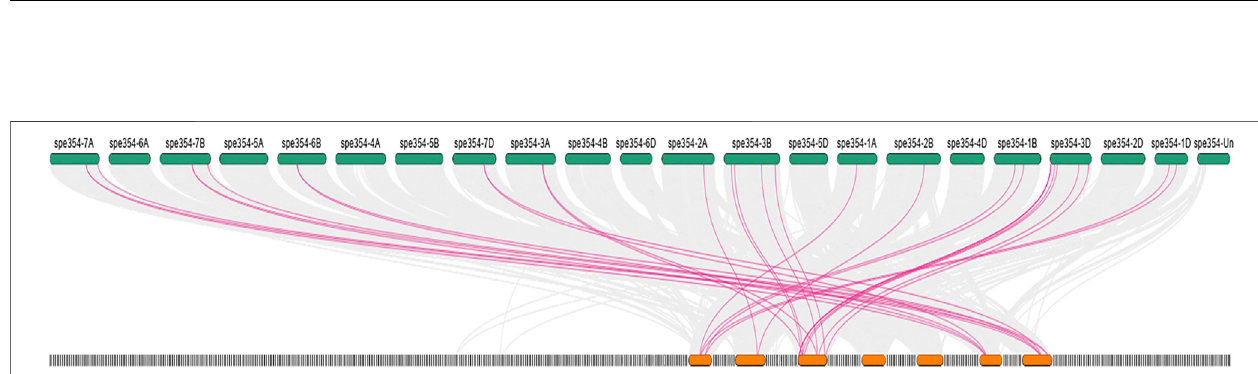
FIGURE 5 | Synteny and collinearity analysis between Triticum aestivum and Aegilops tauschii .